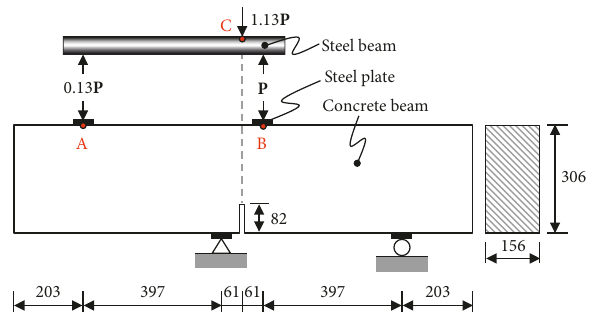
Figure 14: SEN concrete beam: geometry, boundary, and loading conditions (dimensions in